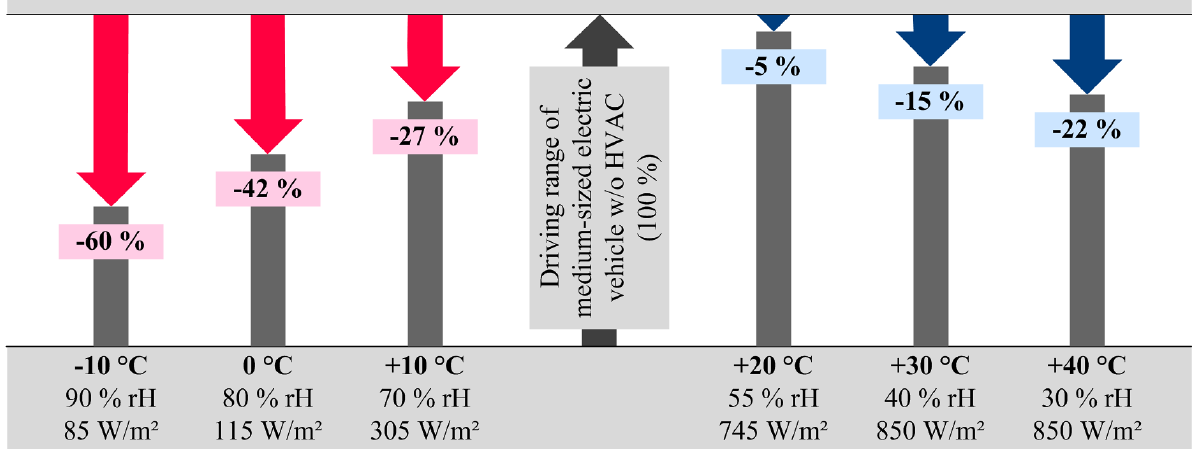
Figure 1. Driving range reduction of a medium-sized EV in cold (heating) and hot (cooling) weather conditions, applying a conventional HVAC system